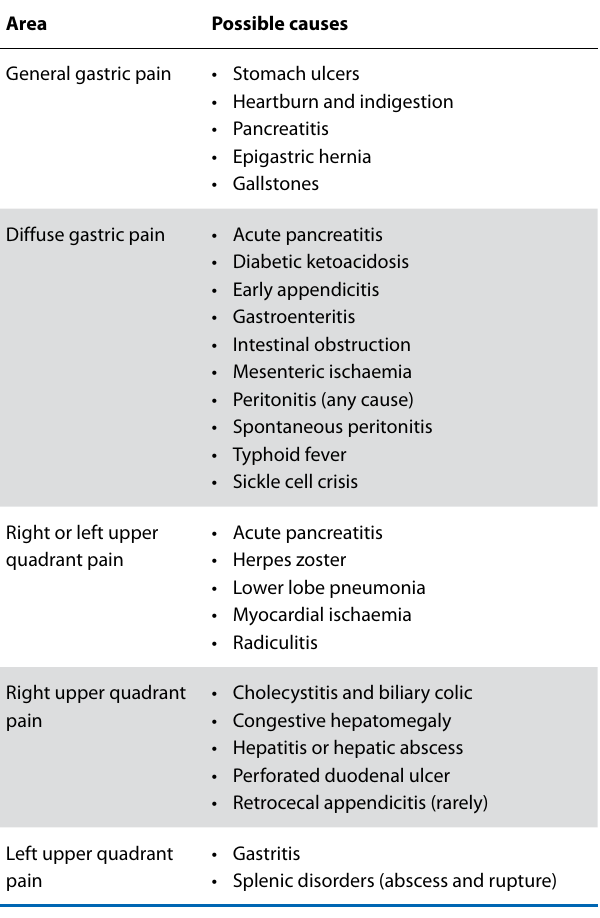
Table 1: Different areas of gastric pain and their associated causes